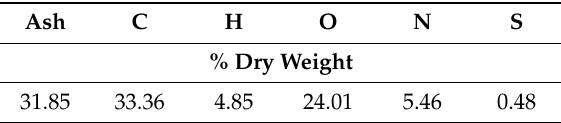
Table 1. Ash and CHONS content of inoculum